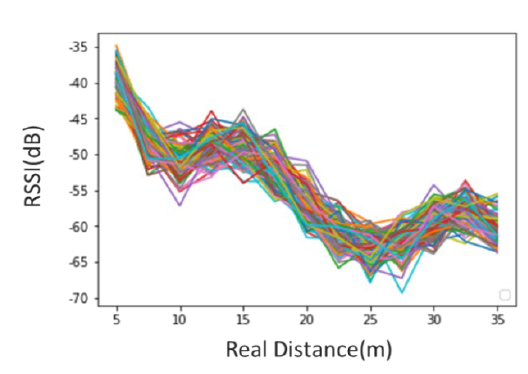
Figure 7. 100 sets of simulated RSSI decay data over distance of 35 m from AP in Figure 5